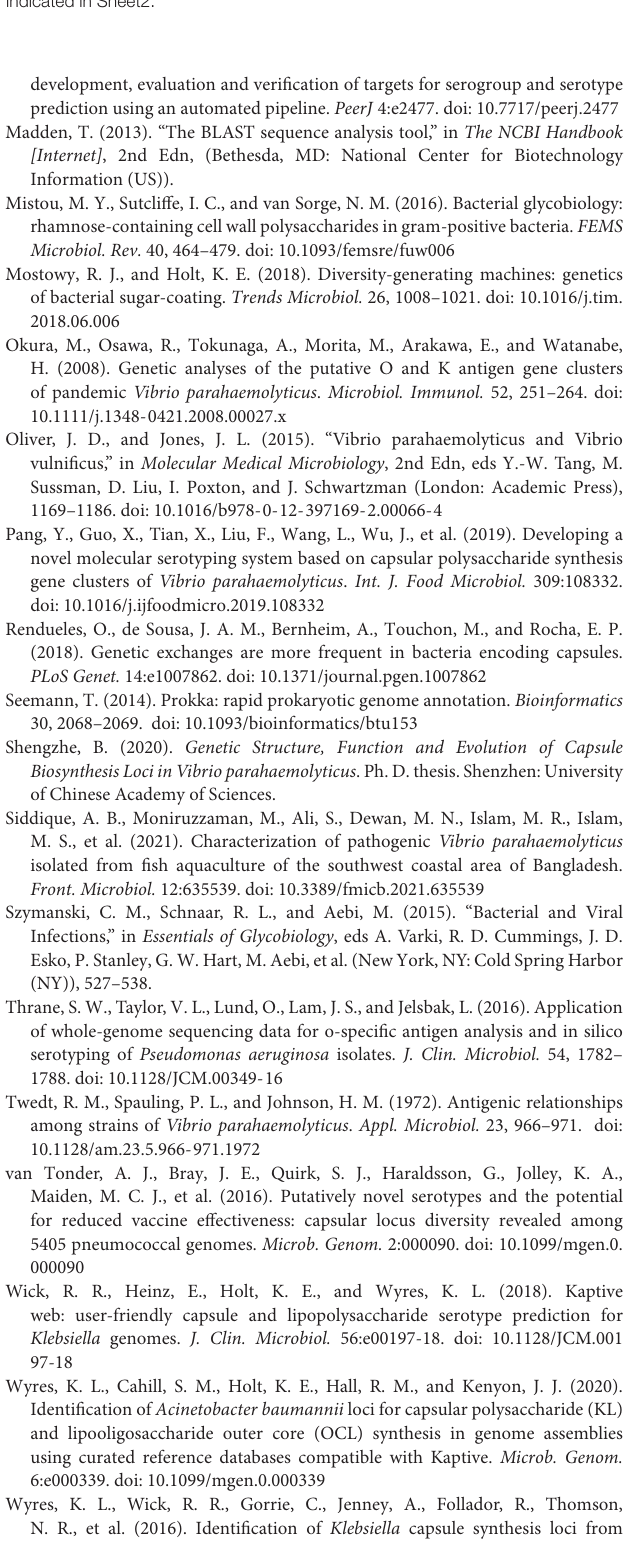
be identified as certain K serogroup scovered by Vpsero. Sheet2 displays the ones that cannot be identified by VPsero and are thus labeled as Ont. As in